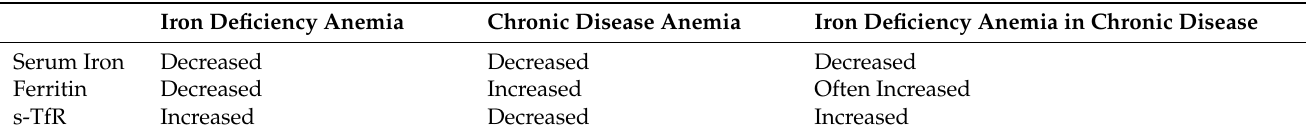
Table 2. Differential diagnosis of